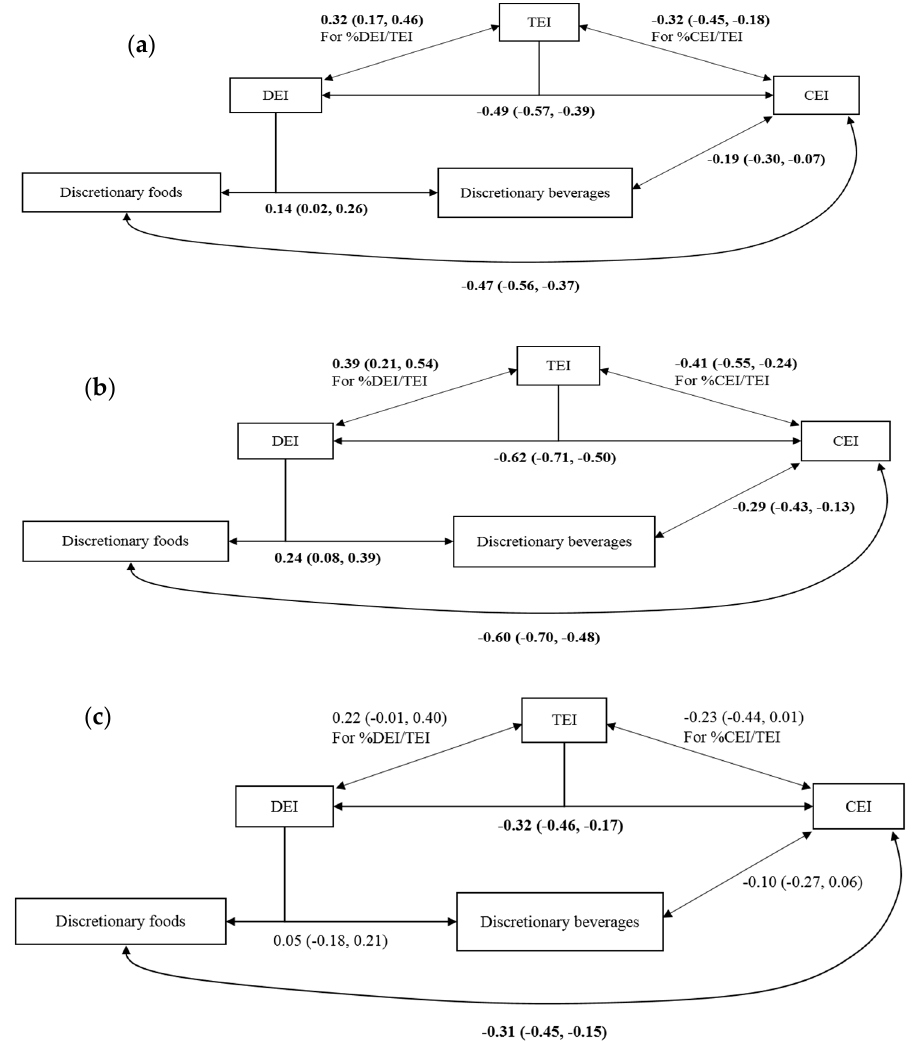
Figure 2. Diagrammatic representations of the correlations among TEI, CEI, DEI, discretionary foods and beverages in: ( a ) the combined participant sample; ( b ) participants without obesity; and ( c ) participants with obesity. Results are presented as cross-equation correlation ρ (95% CI). Models were adjusted for sex (male or female), age (<35 years, 35–64 years, or ≥ 65 years), education (completed post high school education or not), BMI category (has or does not have obesity), day of the week dietary intake was reported (weekend or weekday) and socioeconomic status (SEIFA top quintile or below). Correlations written in bold face are significant at the 5% level. TEI, total energy intake; DEI, discretionary energy intake; CEI, core energy intake.